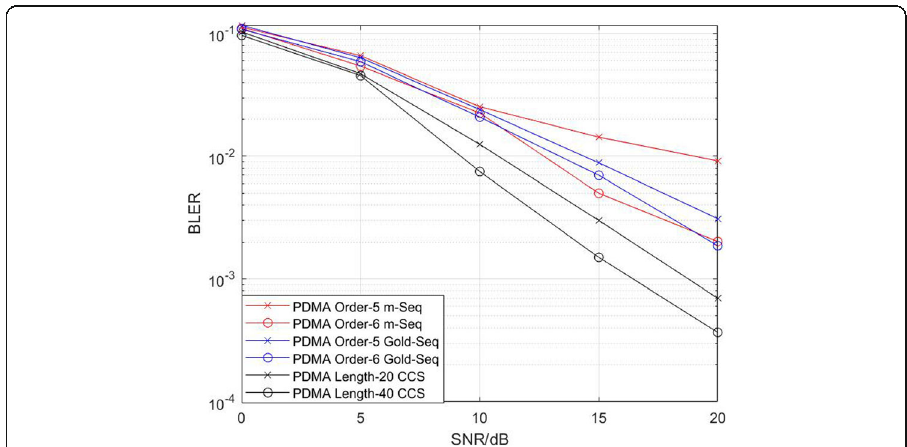
Fig. 9 Performance comparison of three spread spectrum sequences under average power allocation. The comparison of average power allocation performance of 5-order 6-order m-sequence, 5-order 6-order Gold sequence, and CCS with length of 20 and 40. The dimension of pattern matrix is 2 (cid:5)